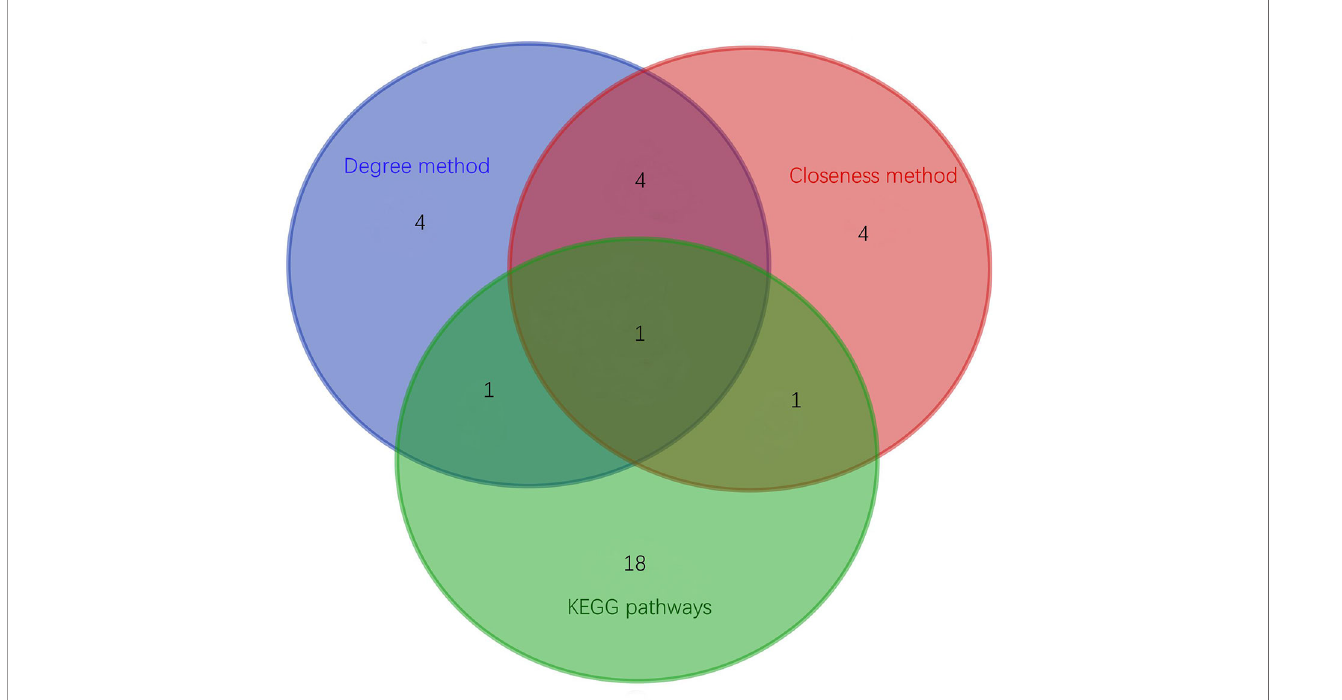
FIGURE 8 | Proteins intersection map of KEGG pathways, Degree method and Closeness method.